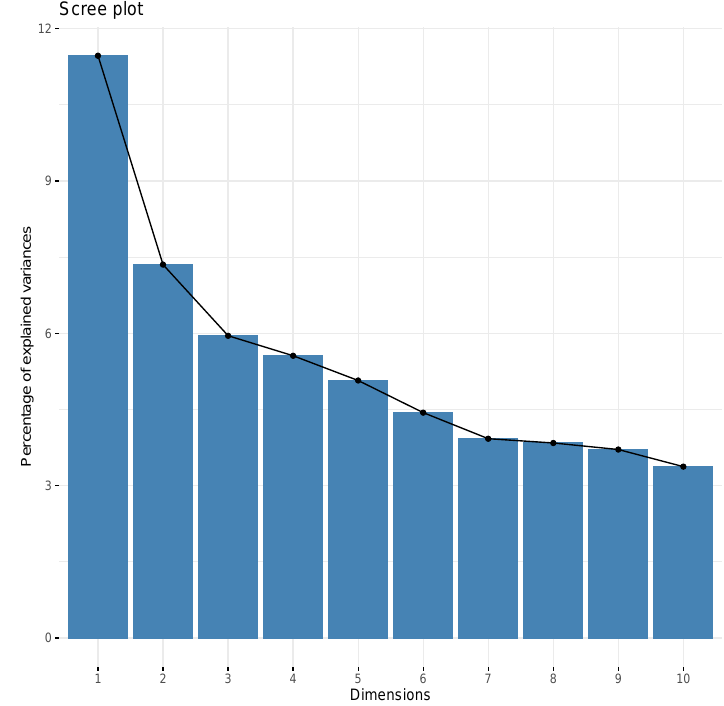
Figure 1. The Scree plot of the factors. The first six factors were further analyzed.